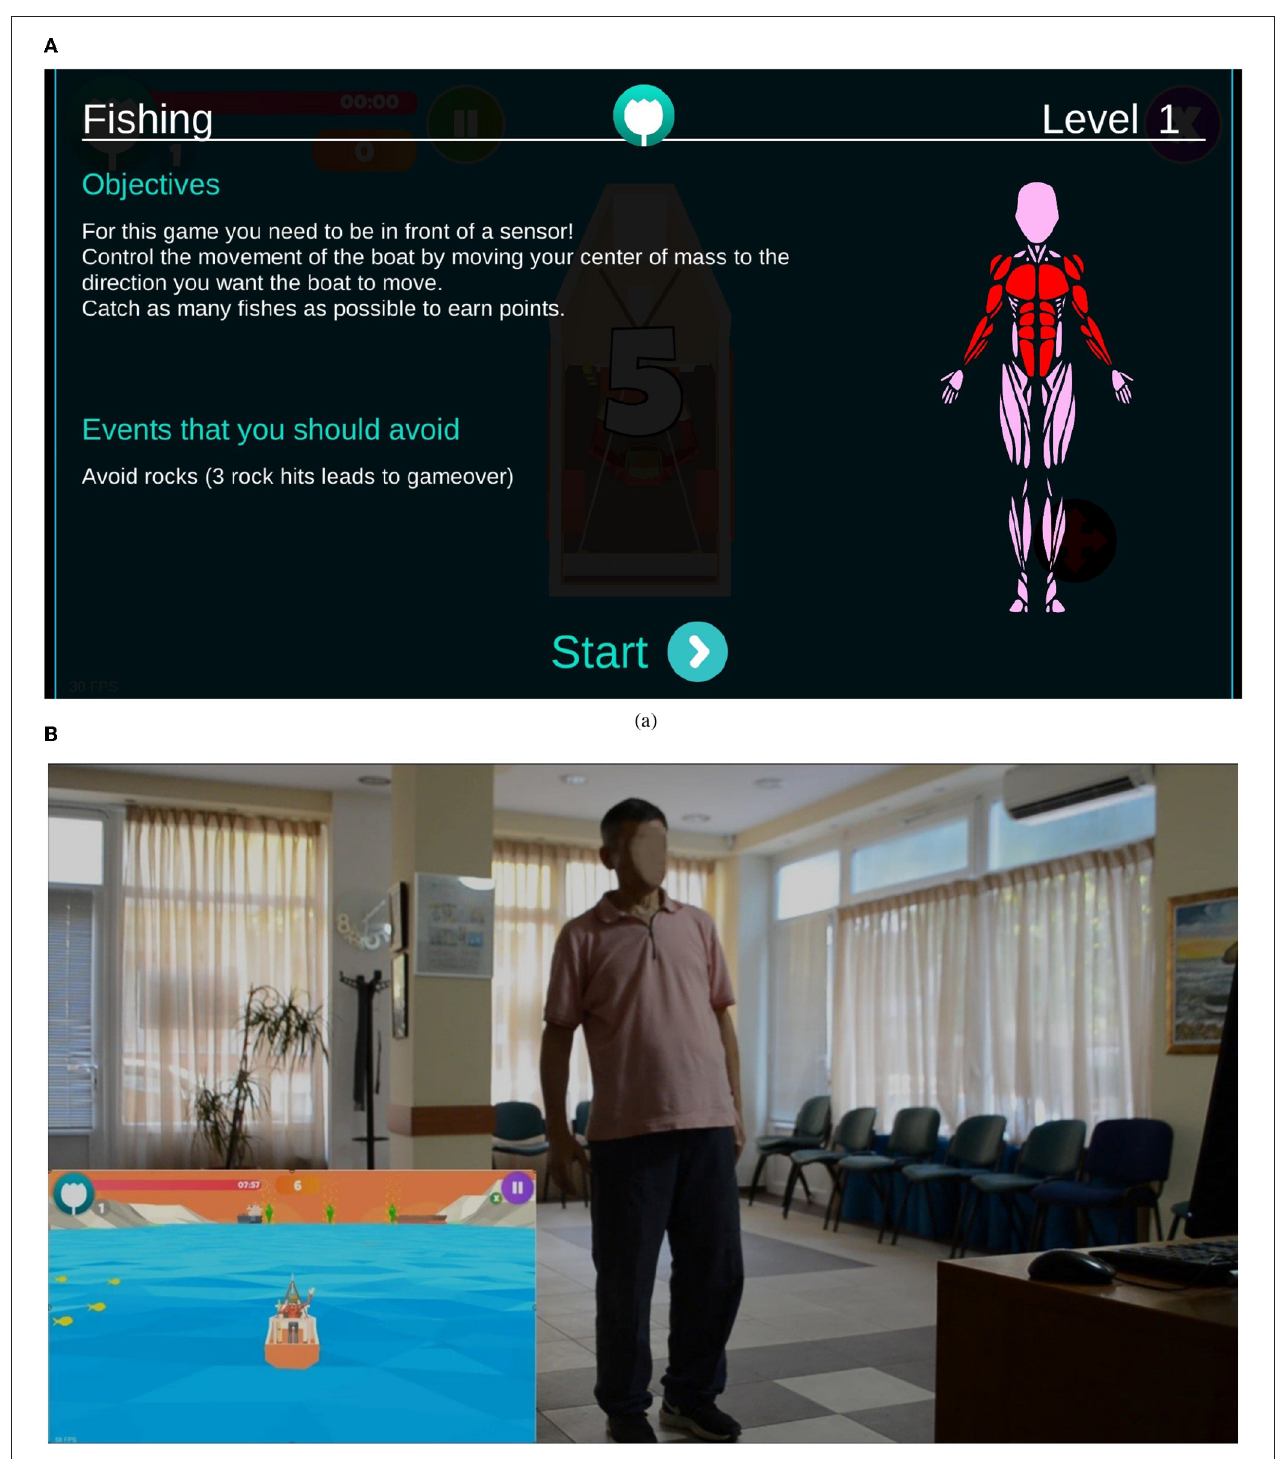
FIGURE 2 | Excerpt from the i-PROGNOSIS PGS ExerGame “Fishing Game.” (A) The interface of the game, including the instructional information and visualization of the targeted muscle groups. (B) The game environment shows a patient with PD controlling the boat movement with his body. is saved and transmitted to the attending physician via the i- real-time feedback, motivating improvement toward 100% PROGNOSIS Azure-based dashboard. More details about the accuracy. Clearly, the use of iMAT does not require any visit to iMAT could be found in Dias et al. the clinical environment, and the accuracy per each test session